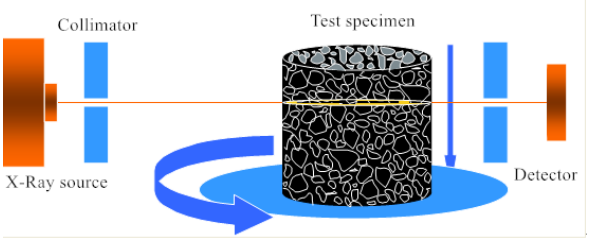
Fig. 1 Industrial CT scanning